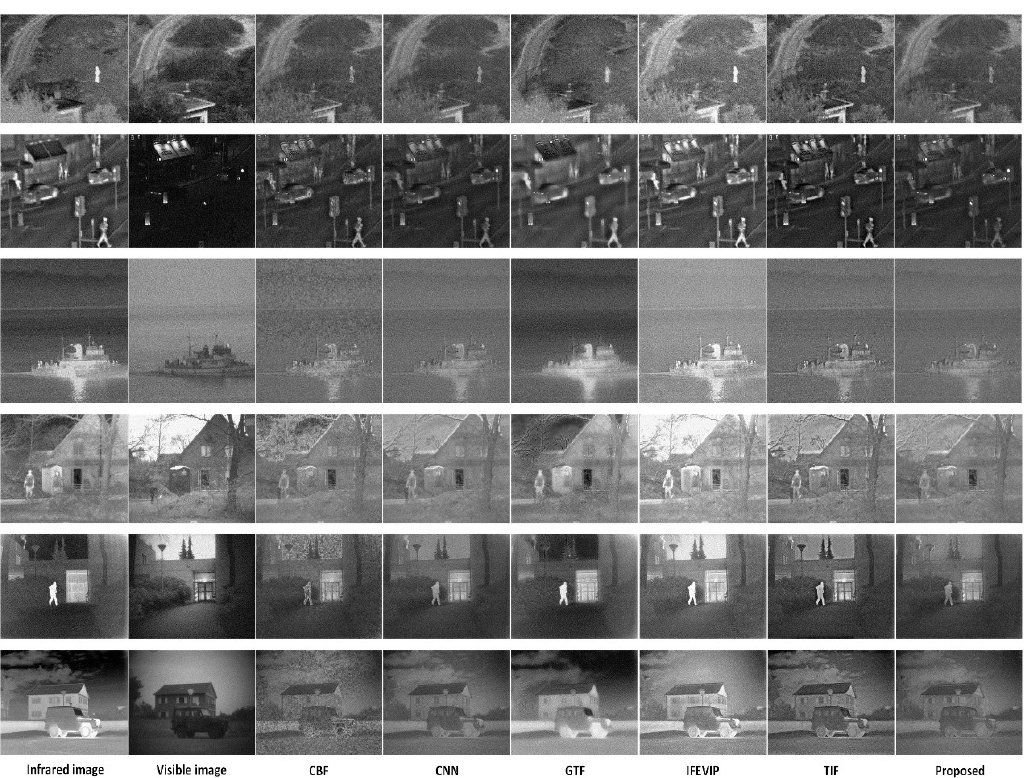
Figure 10. Fusion results of noisy images ( 𝜎 = 20)